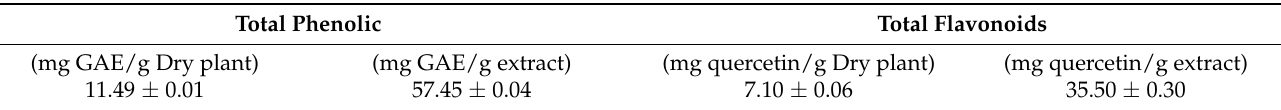
Table 3. Total phenolic and flavonoid contents of L. libyca (methanol extract). Total Phenolic Total Flavonoids (mg GAE/g Dry plant)